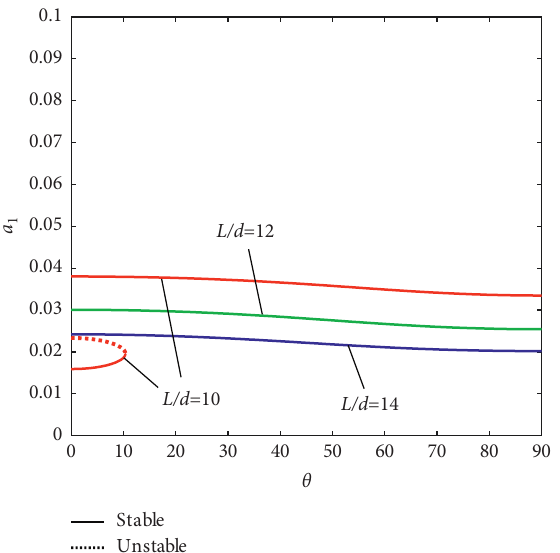
Figure 17: Amplitude versus ply angle with different cutting force coefficients (L/d � 10, c � 0.01, σ � 2, case I).